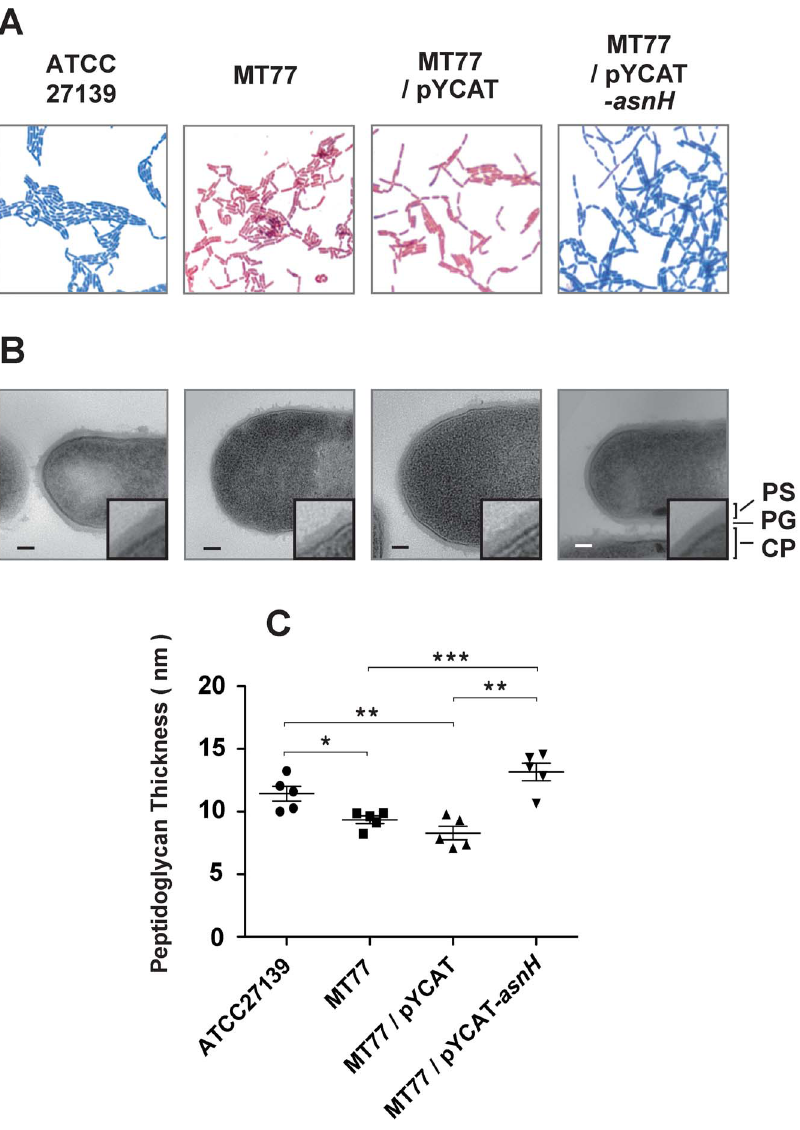
Figure4. Micrographs of L.casei cells. (A) Gram staining was performed using Fiber G. The cells were observed under a light microscope ( 6 1000). (B) Representative micrographs indicating cell morphologies in several different fields. Digitally magnified ( 6 3) views of typical cell surfaces are shown in the insets. Scale bars=100 nm. PS, polysaccharide; PG, peptidoglycan; CP, cytoplasm. (C) Peptidoglycan thickness of L. casei cells are presented as the means 6 standard error of the mean (SEM) (n=5). Statistical significance was calculated using the Student’s t -test. *, p , 0.05; **, p , 0.01; ***, p ,